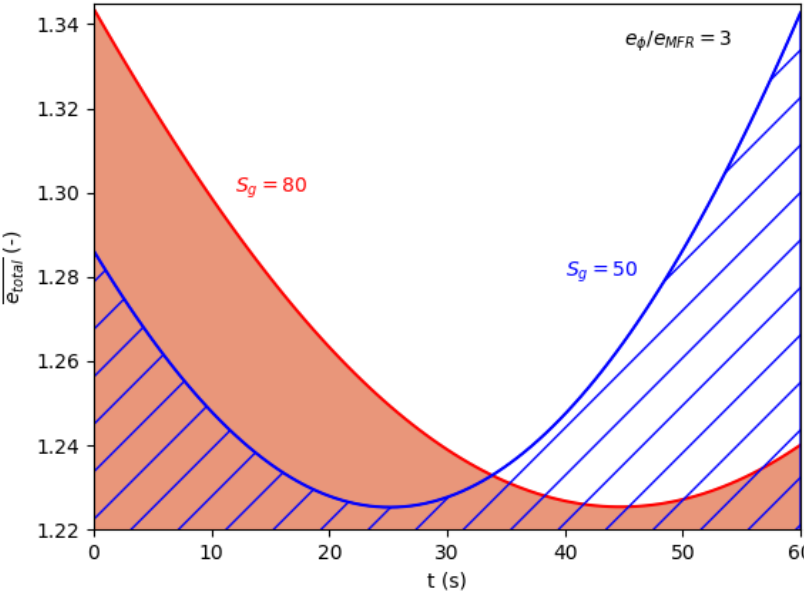
Figure 11. Illustration of the C2 criterion.